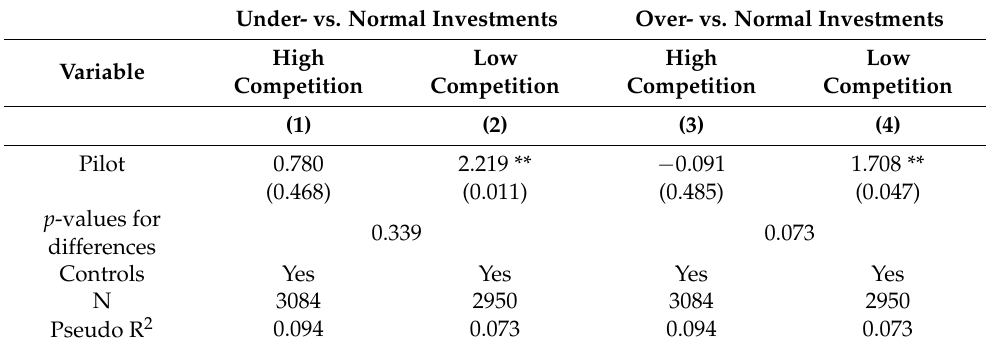
Table 5. Cross-sectional analyses: Customer competition. Under- vs. Normal Investments Over- vs. Normal